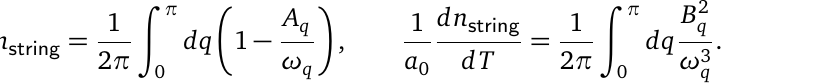
Figure 10: The δ dependence of the defect triangle density, n def , and its crossover scaling. Monte Carlo simulations are run for L = 24 for a number of δ values and error bars are smaller than the point sizes. (a) n def as a function of T for variable δ . (b) Collapse using the crossover scaling function of Eq. 13 gives α = 0.5 and φ =